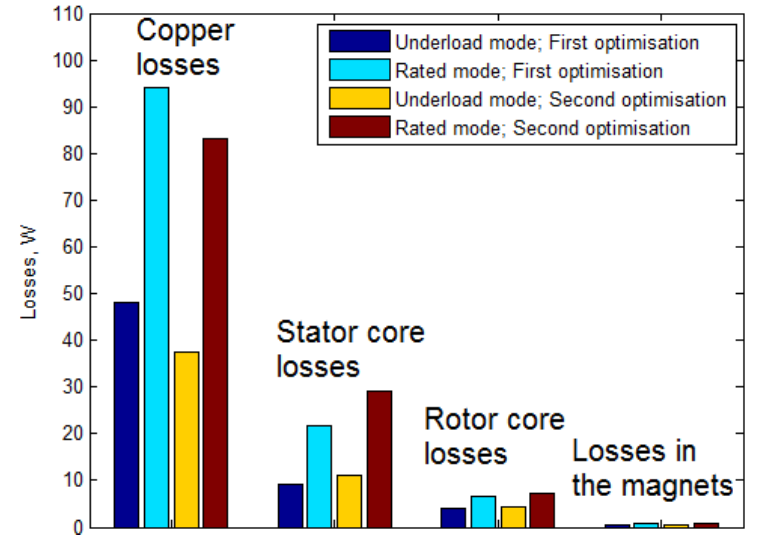
Figure 18. Losses for both FRMs in two modes.